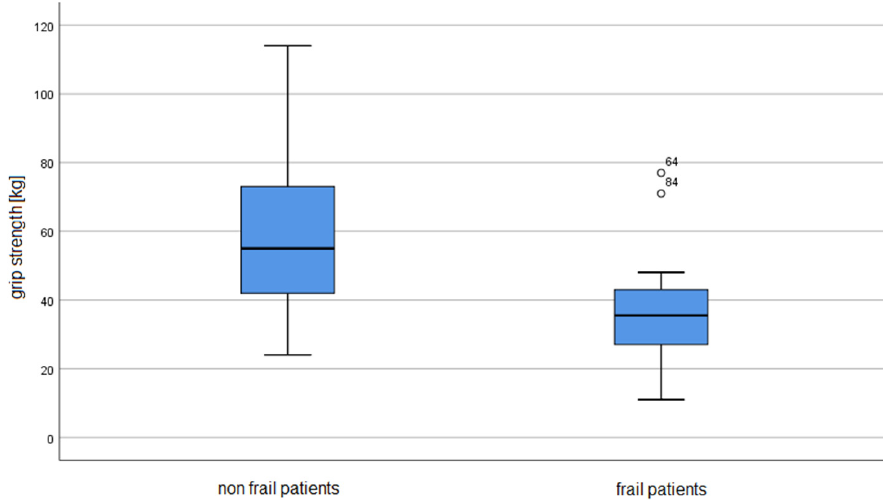
Figure 1. The result of the hand grip test in the study group.